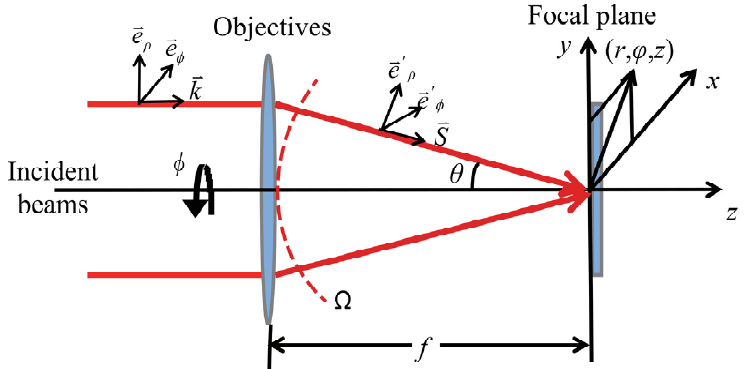
Figure 1. Schematic diagram of a vector vortex beam under a tightly focused condition, where the focal region is located at z = 0.